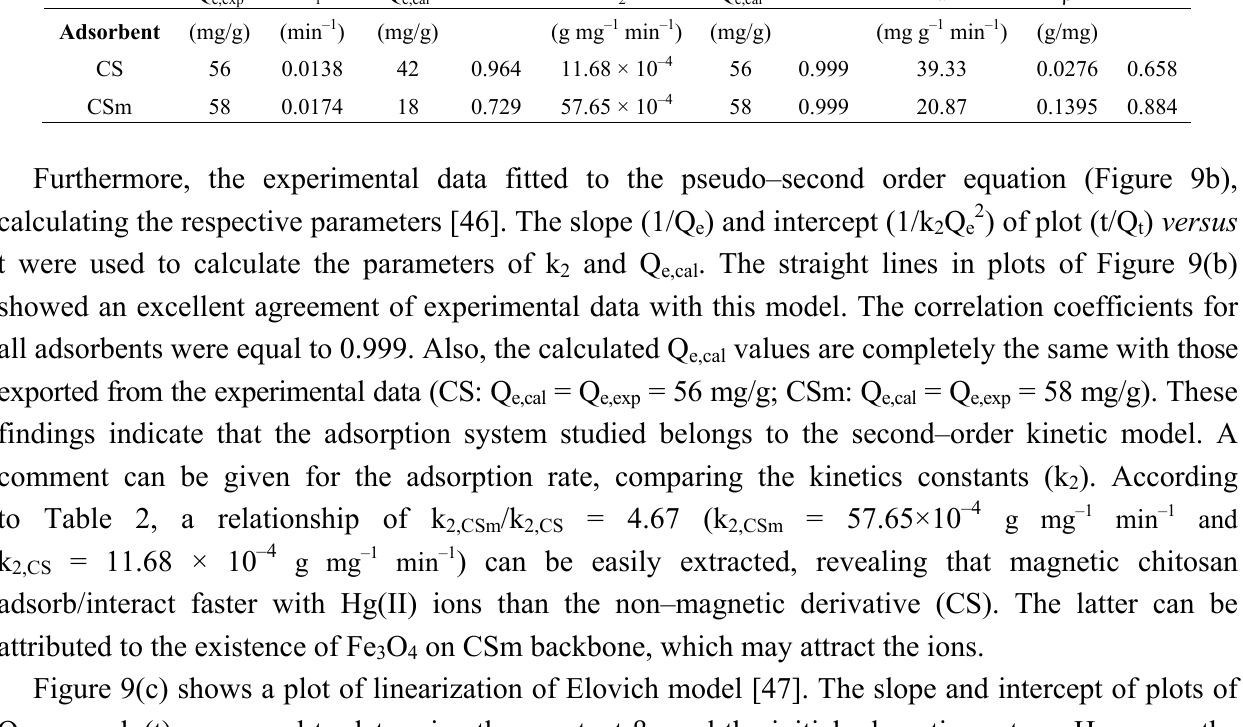
Table 2. Kinetic constants for the adsorption of Hg(II) onto CS and CSm ([Hg(II)] Pseudo–first order Pseudo–second